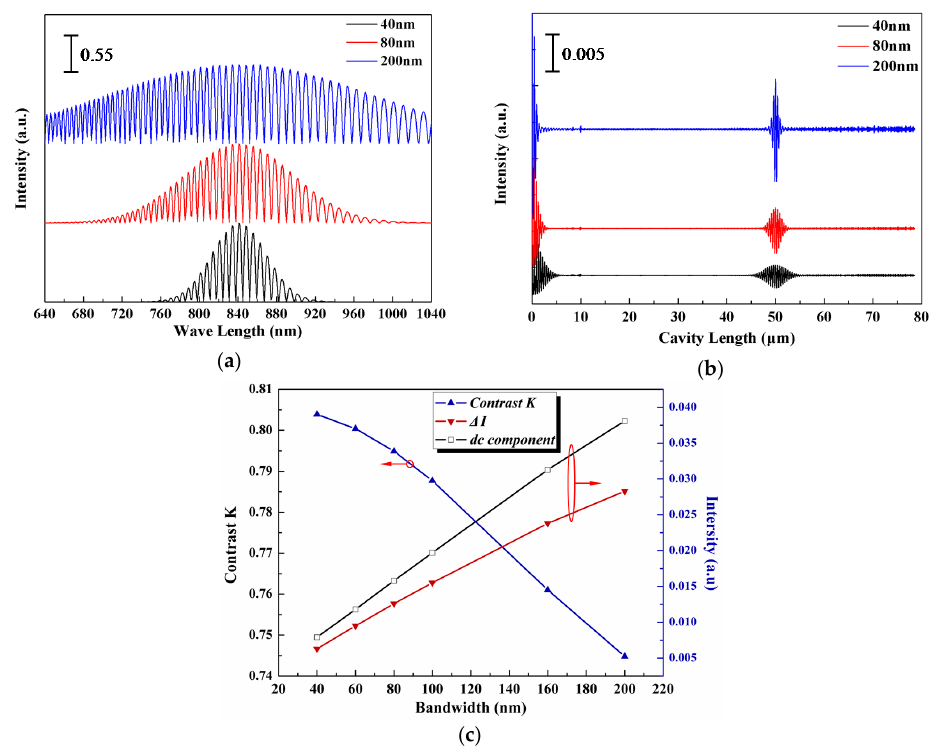
Figure 5. The simulated signal with different bandwidth of 40 nm, 80 nm and 160 nm: ( a ) the F-P reflective light intensity, and ( b ) the demodulation signals; ( c ) the contrast K, Δ I, dc component at different bandwidth of SLED.